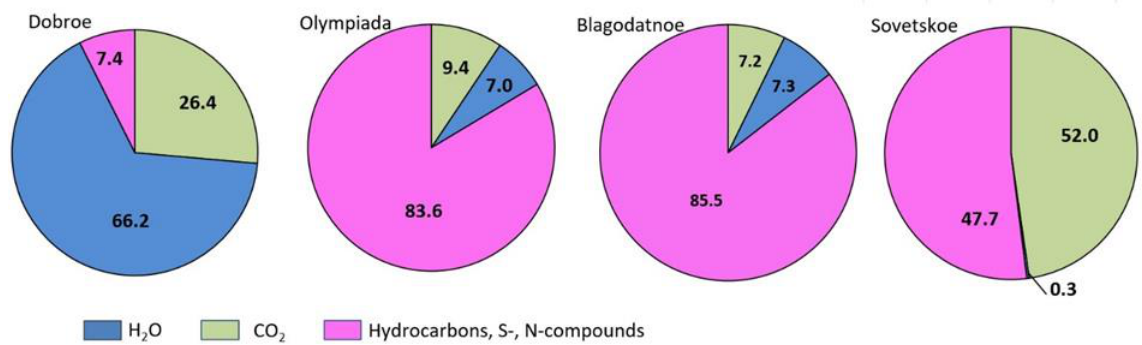
Figure 13. Content (rel.%) of hydrocarbons, carbon dioxide, and water in fluids from the Dobroe (arsenopyrite, sample D–2–12), Olimpiada (arsenopyrite, sample 503–39) [22], Blagodatnoe (native gold, sample 310–13) [61], and Sovetskoe (native gold, sample 375) [36].